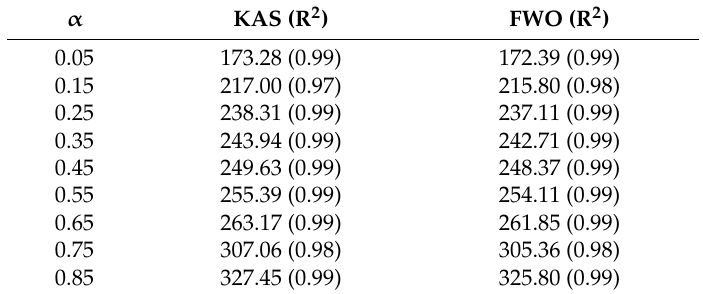
Table 4. Activation energy of F-lignin@APP20 / EP obtained from the KAS method and FWO method.